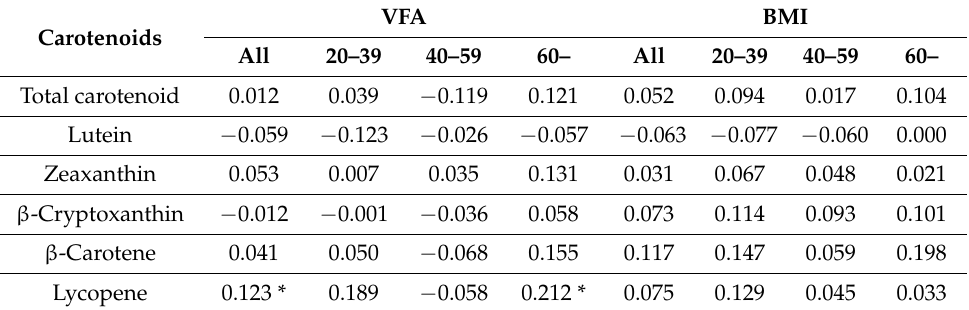
Table 3. Adjusted standard partial regression coefficient between visceral fat area (VFA) or body-mass index (BMI) and carotenoids (male).